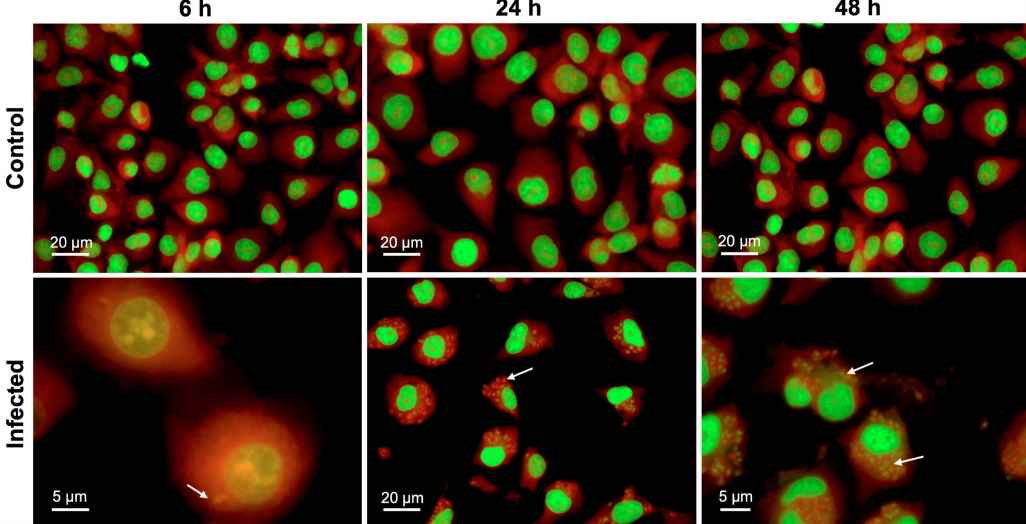
Figure 2. T. gondii development within BMECs. Representative images of BMECs infected by T. gondii tachyzoites and stained with AO at 6, 24, and 48 hpi. Numerous intracellular tachyzoites (indicated by arrows) were observed in infected BMECs, particularly at 48 hpi. Cellular DNA and RNA are shown in green and red,